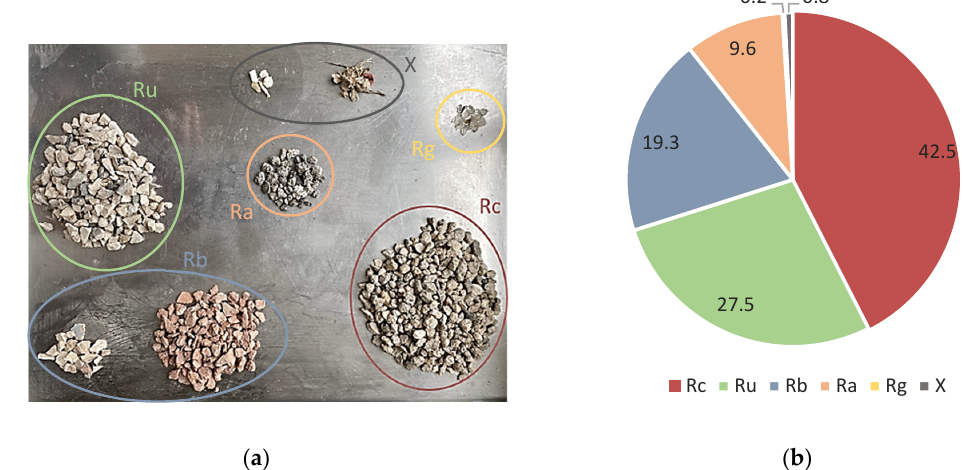
Figure 3. ( a ) CDW-A separation into its constituents and ( b ) classification of CDW-A constituents: concrete, concrete products, mortar and concrete masonry units (Rc); unbound aggregates, natural stone and hydraulically bound aggregates (Ru); clay masonry units (Rb); bituminous materials (Ra); glass (Rg); other materials, including cohesive, metals, plastic, rubber, non-floating wood and gypsum plaster (X). CDW-A in cementitious mortars was incorporated in its natural state (non-carbonated) and subjected to forced carbonation in a chamber, at 23 ◦ C, 60% of relative humidity